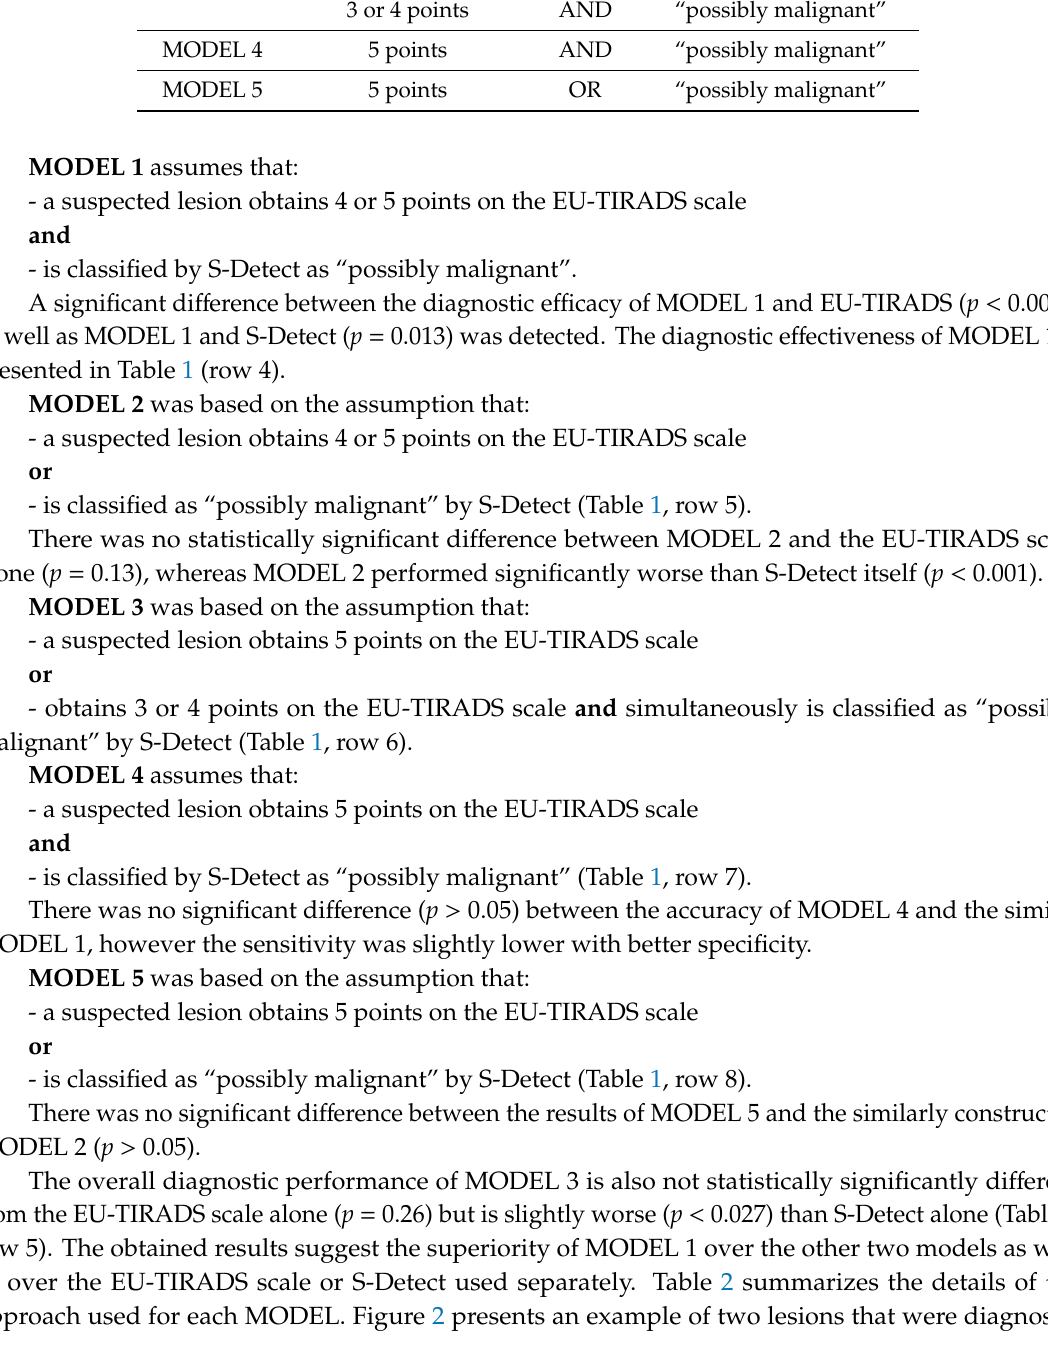
Table 2. Description of the mixed models. The S-Detect classification was based on computer-aided diagnosis (CAD). The nodules were classified with an European Thyroid Imaging Reporting and Data System (EU-TIRADS) score independently by two physicians on the basis of recorded examinations. EU-TIRADS Scale S-Detect Classification MODEL 1 4 or 5 points AND “possibly malignant” MODEL 2 4 or 5 points OR “possibly malignant” 5 points - - MODEL 3 3 or 4 points AND “possibly malignant” MODEL 4 5 points AND “possibly malignant” MODEL 5 5 points OR “possibly